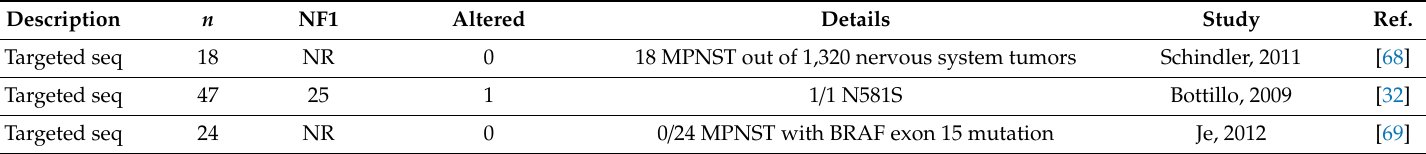
Table 2. Less frequent genomic alterations identified in